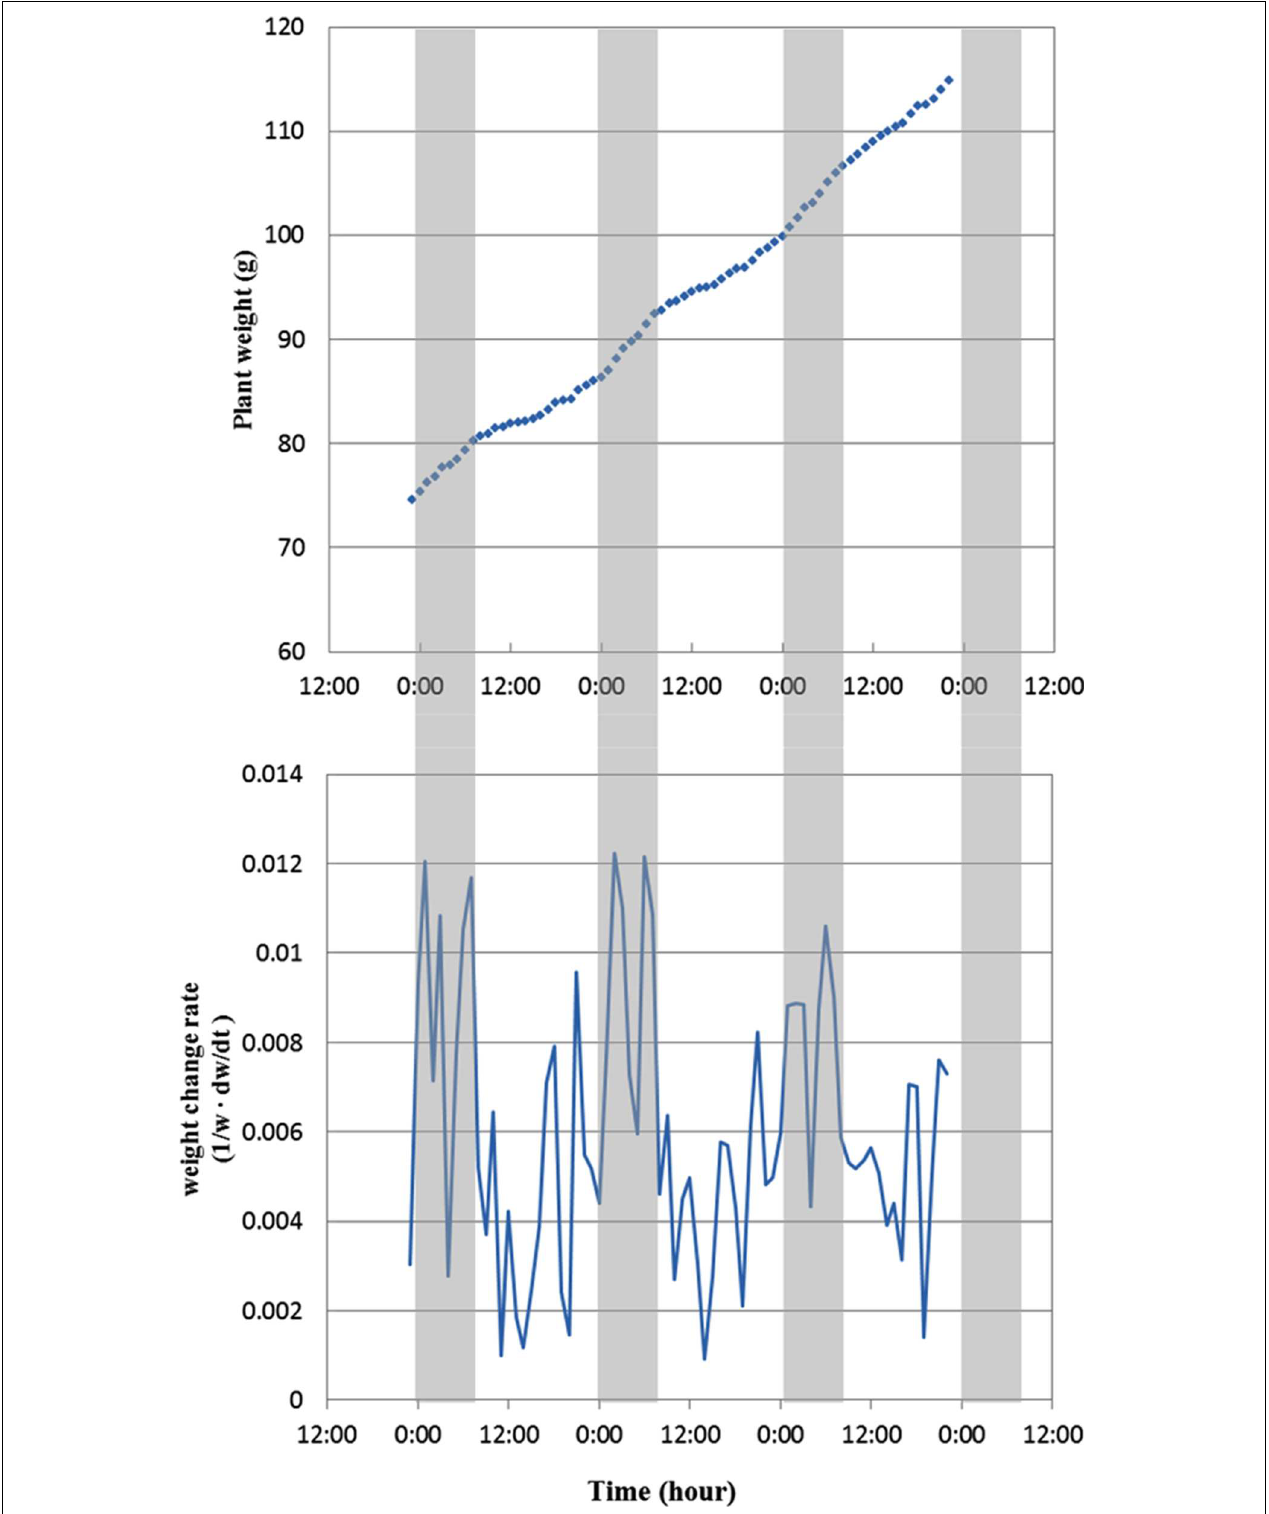
FIGURE 6 | Diurnal change of plant weight (top) and weight change rate (bottom) from day 15 to day 18 of the growing period. The gray area indicates the dark period, and white area is light period. The weight change rates are calculated as the weight difference between previous and current hour over current hour